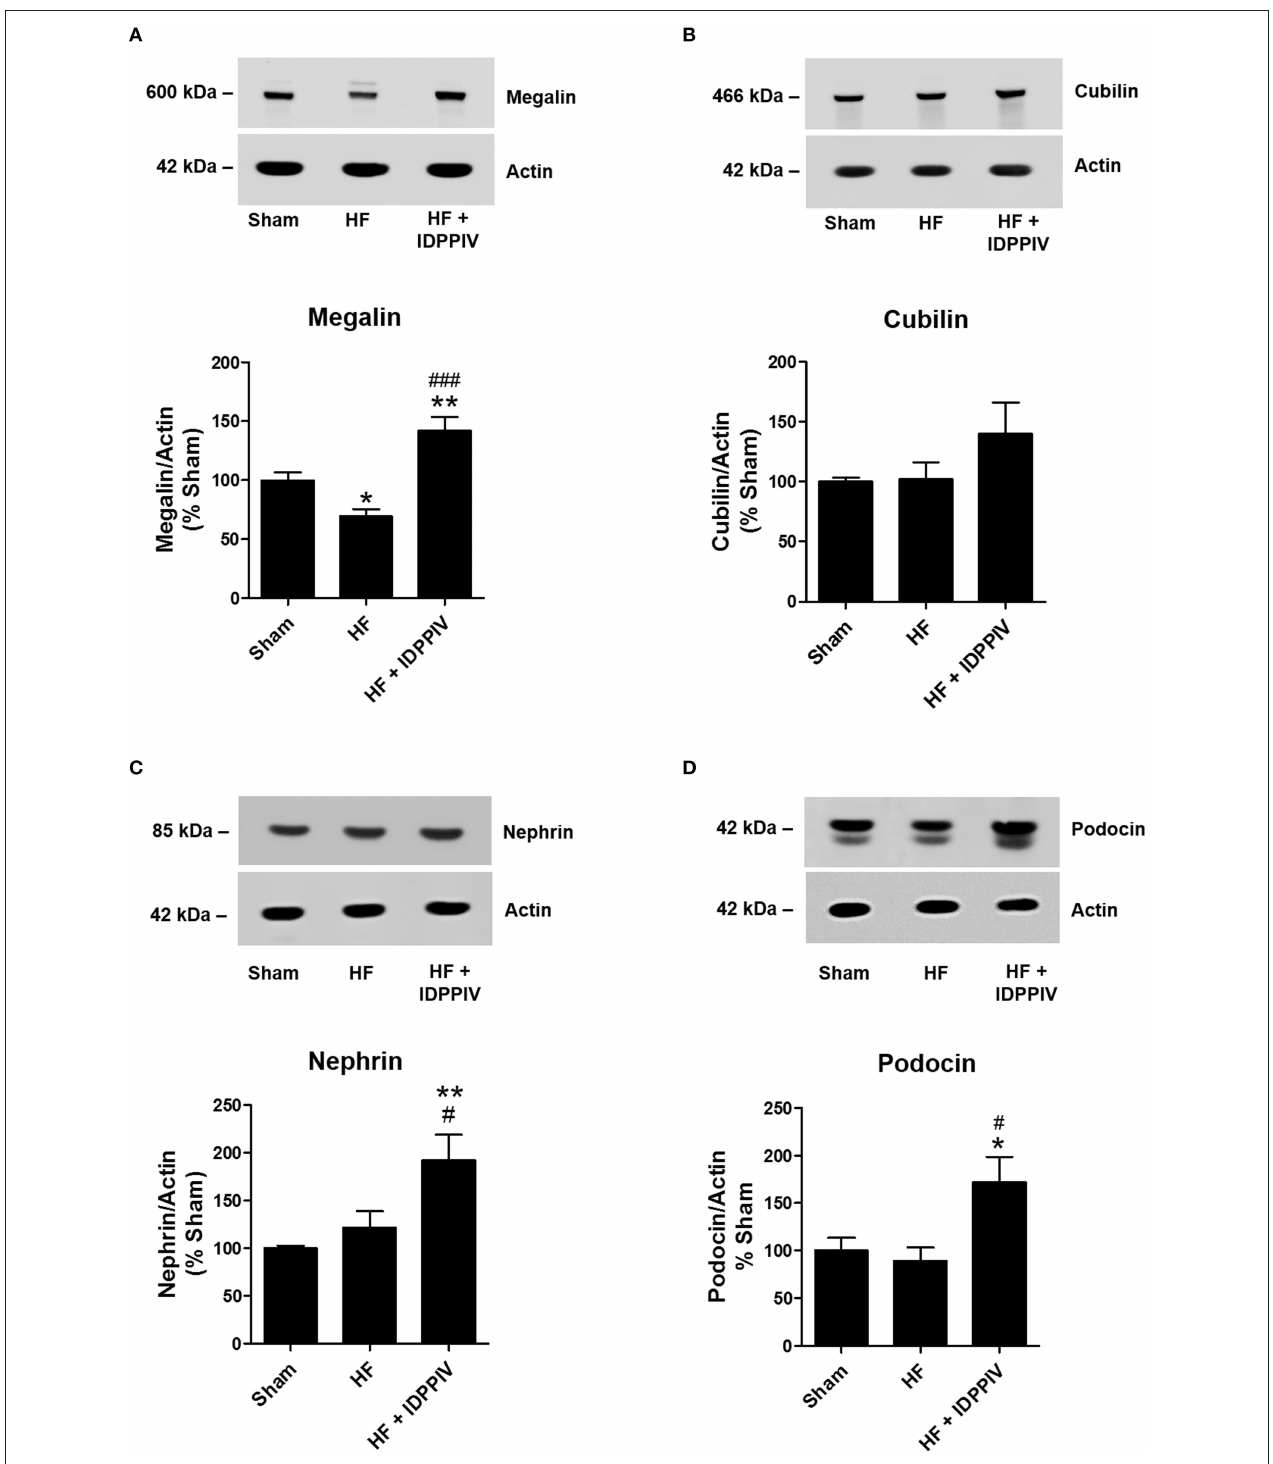
FIGURE 9 | The antiproteinuric effects of DPPIV inhibition are associated with upregulation of megalin, nephrin, and podocin expressions in the kidneys of HF rats. Equal amounts of renal cortical proteins isolated from sham and HF rats treated with vildagliptin (HF + IDPPIV) or vehicle (HF) (10 µ g for megalin and cubilin, 30 µ g for nephrin and podocin and 5 µ g for actin) were subjected to SDS-PAGE, transferred to a PVDF membrane and incubated with primary antibodies against (A) megalin (1:50,000), (B) cubilin (1:1000), (C) nephrin (1:11,000), or (D) podocin (1:11,000). Actin was used as an internal control. Values are means ± SEM. * p < 0.05 and ** p < 0.01 vs. Sham. # p < 0.05, ### p < 0.001 vs. HF.